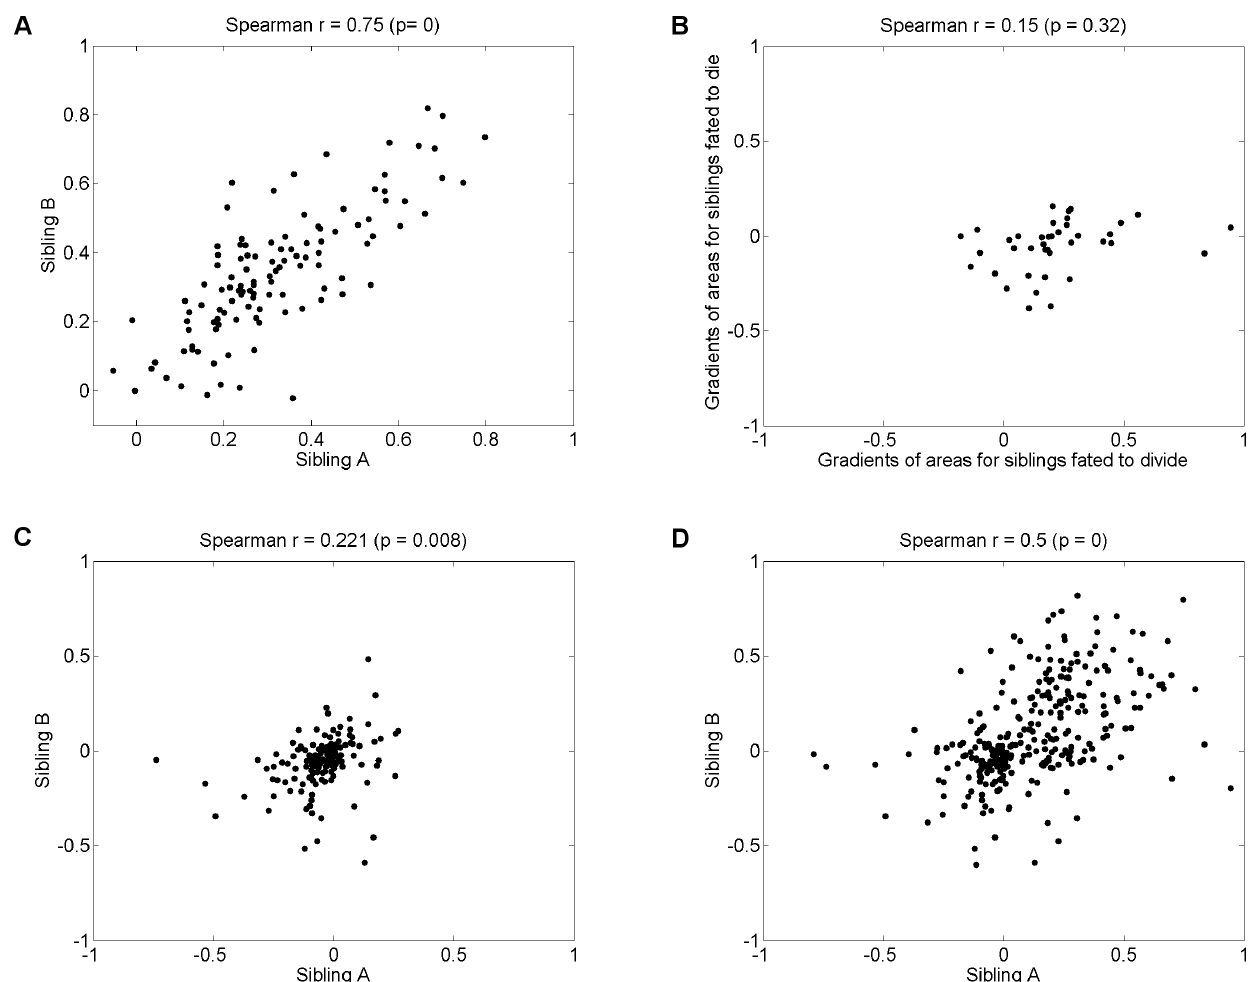
Figure 7. Correlations between area-gradients of sibling cells. The area gradient is computed by applying a median filter (size 12 measurements) over each track’s size measurements, to reduce noise. A line was then fitted to the resultant points and the gradient of the line is reported. This measures the rate of growth rather than overall size attained. Regardless of generation, there are strong positive correlations between siblings when both siblings divide (A). When one sibling dies and another divides (B), the rates of growth are only weakly correlated. Since the gradient is computed throughout the life of the cell, this suggests that fate determines cell growth early in the life of the cell reducing growth of the dying cell compared to its sibling. In the case of both siblings dying (C), both siblings rates of growth are clustered around zero with a slight positive correlation, although as discussed in section 2.4 any apparent growth in the final generation may be an artefact of increased fluorescence intensity and automatic segmentation. Panel (D) shows correlations for all fate combinations, an intermediate correlation as expected because the division correlation is diluted.